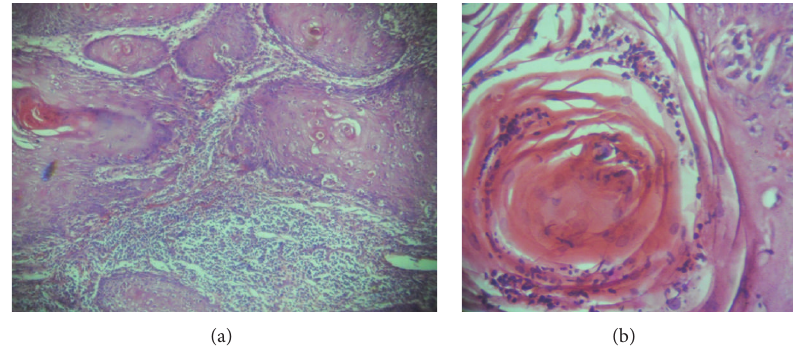
Figure 3: (a) A photomicrograph showing a well-differentiated tumor made up of malignant squamous epithelial cells disposed in islands and cords. Numerous keratin pearls are seen scattered throughout. (b) A photomicrograph showing a keratin pearl in higher magnification. Note: infiltration by neutrophils of the keratin pearl (H&E × 100).